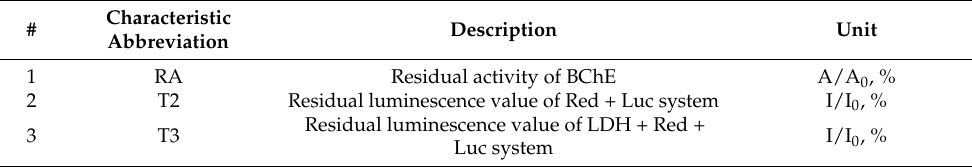
Table 1. Summary of characteristics of the soil